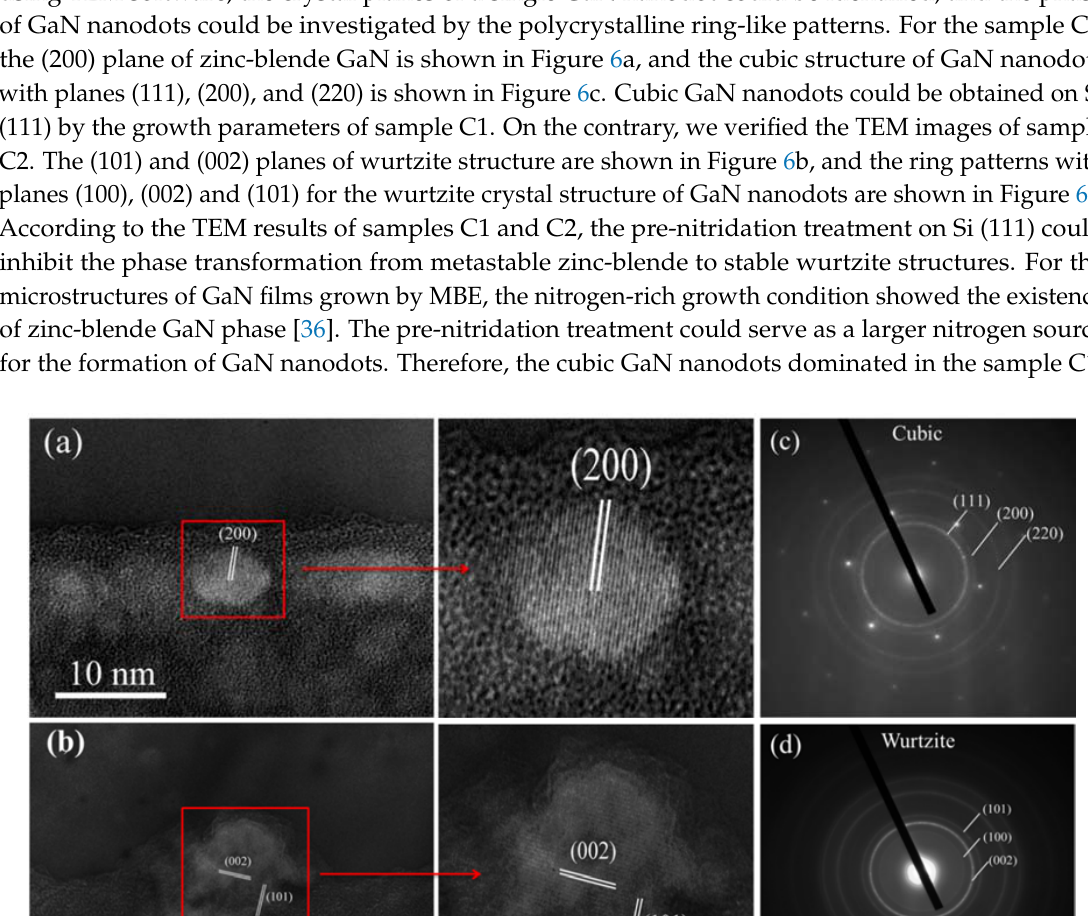
Figure 7. Cross ‐ section HRTEM images of a single GaN nanodot: sample C3 ( a ) and sample C4 ( b ); Selective ‐ area diffraction patterns of GaN nanodots: sample C3 ( c ) and sample C4 ( d ).